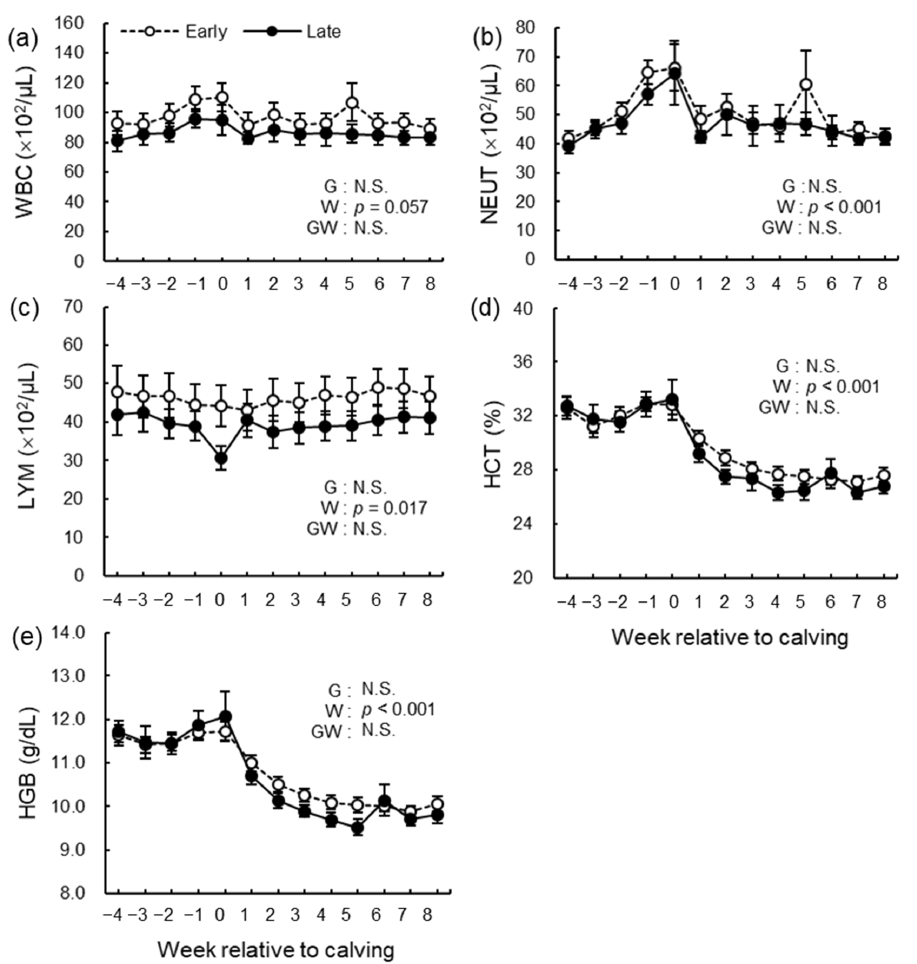
Figure 13. Blood counts of ( a ) white blood cell (WBC), ( b ) neutrophils (NEUT), ( c ) lymphocytes (LYM), ( d ) hematocrit (HCT), and ( e ) hemoglobin (HGB) from −4 to 8 wk relative to calving for cows classified into the early group (Early) or the late group (Late). Early = cows with endometrial inflammation converged within 4 wk, n = 17; Late = cows with endometrial inflammation converged at or after 5 wk, n = 16. The week of calving is defined as 0 wk. G = group effect; W = week effect; GW = group-by-week interaction. Data are shown as mean ± SEM. 3.7. Blood Hp Blood concentrations of Hp are shown in Figure 14. There were no differences be- tween groups.